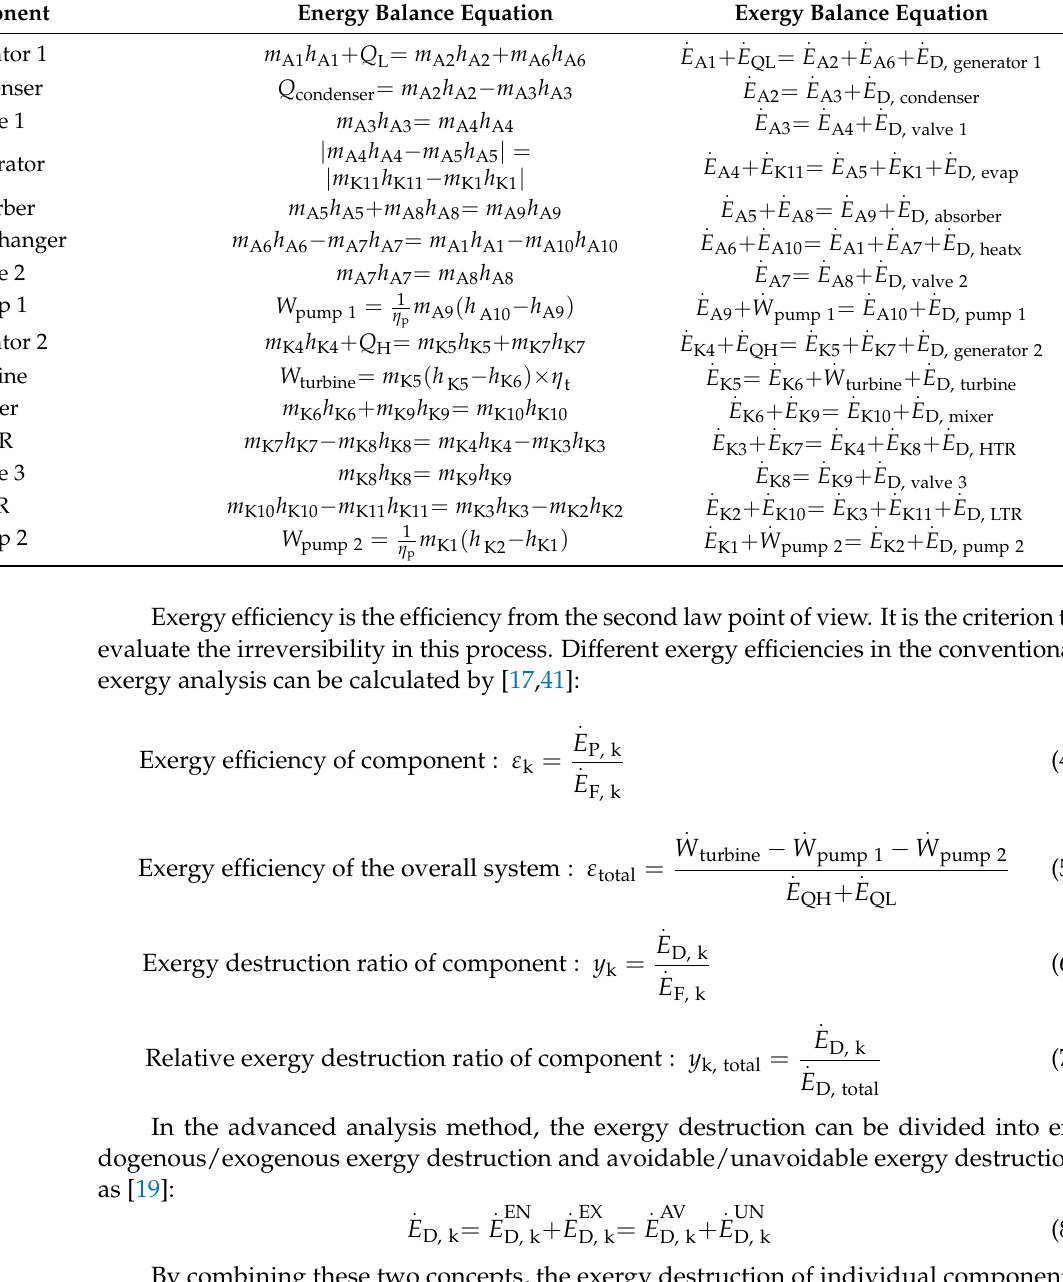
Table 1. Mathematical equations for each